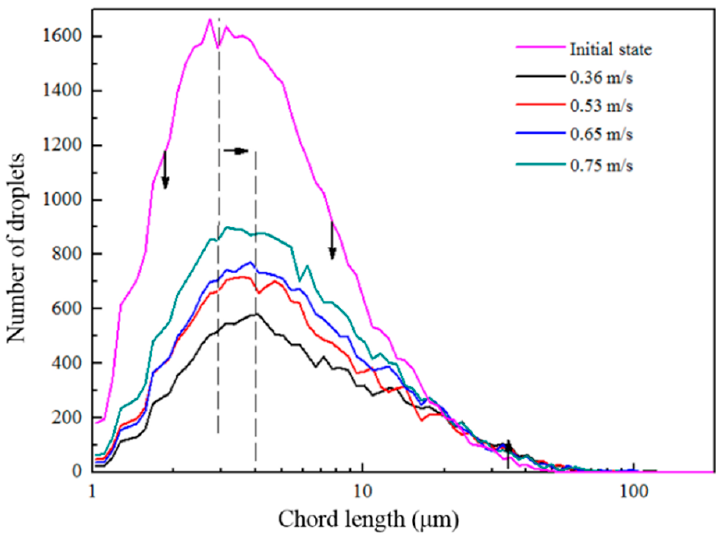
Figure 23. Variations of water droplet number under different chord lengths.